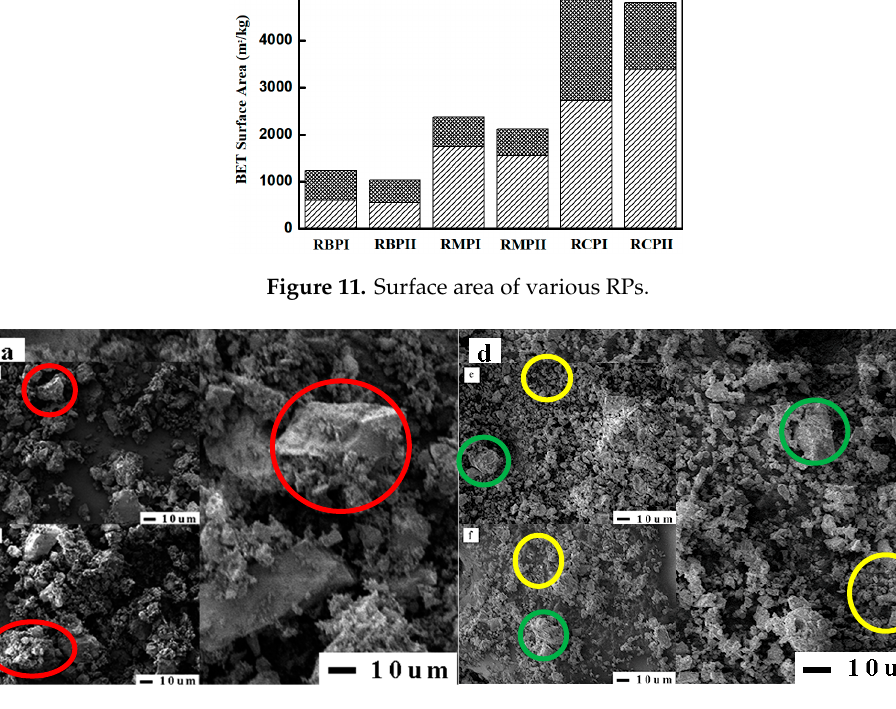
Figure 12. Microstructure of various RP particles: ( a ) RCPII, ( b ) RBPII, ( c ) RMPII, ( d ) RCPI, ( e ) RBPI, and ( f ) RMPI.